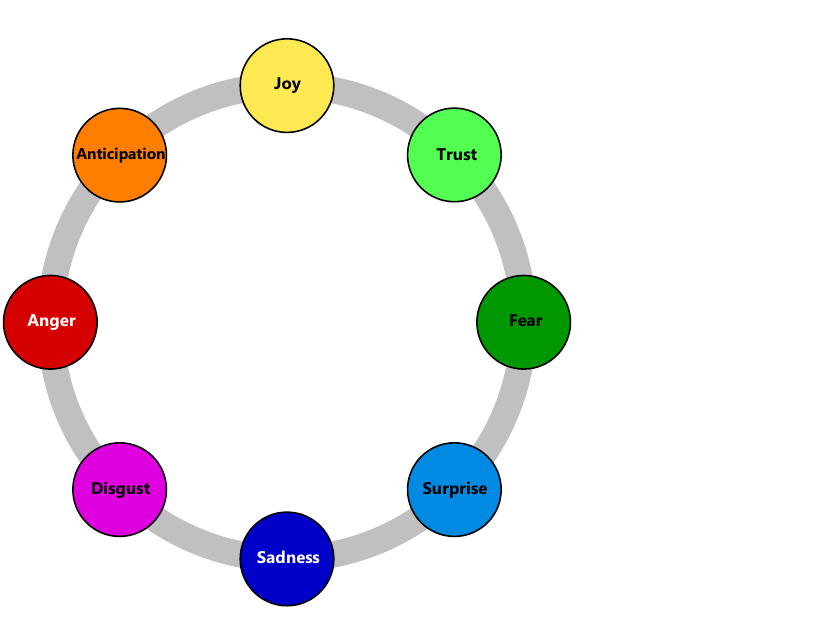
Figure 9. Plutchik’s wheel of emotions 40